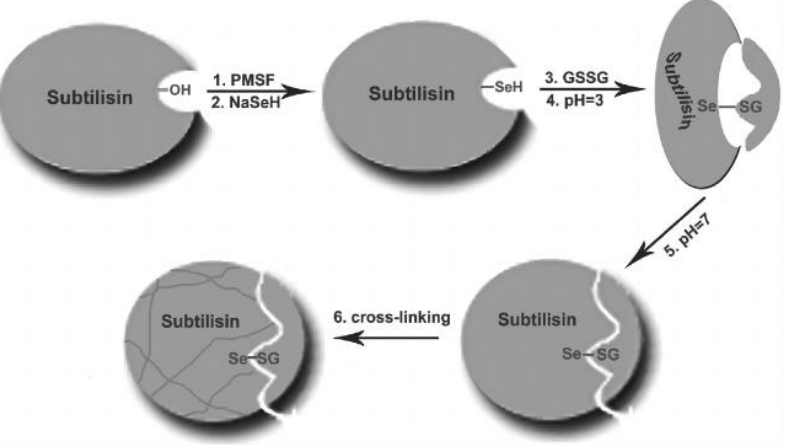
Figure 3. Artificial selenoenzyme designed by bioimprinted strategy. Reproduced with permission from L. Liu, et al. [25].